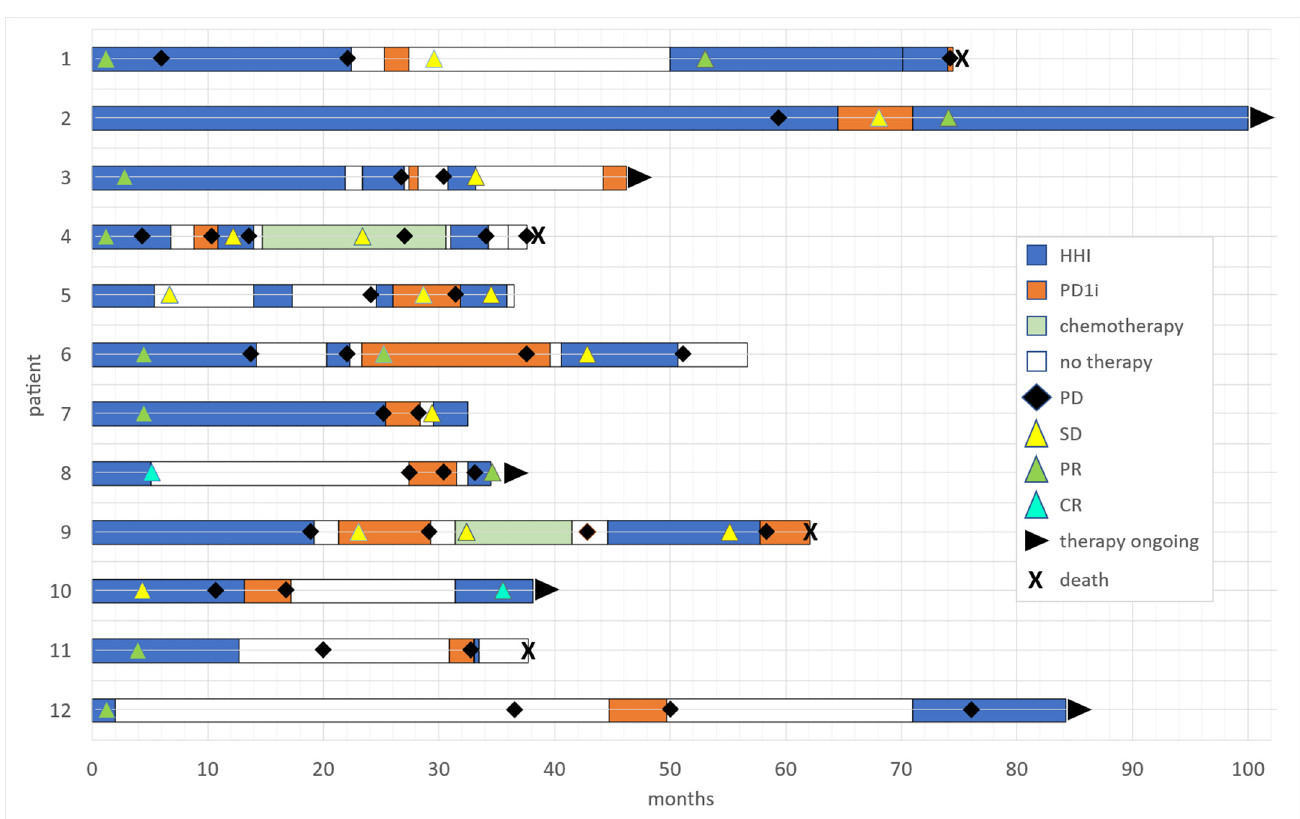
Figure 1. Course of treatment across all 12 patients depicted as swimmers plot.